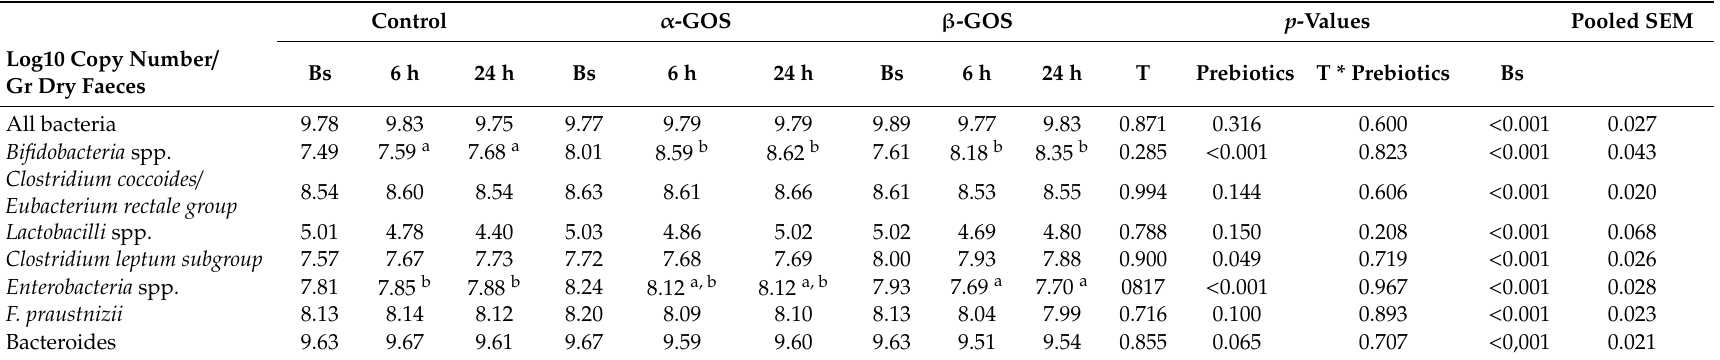
Table 2. Microbiota population from in vitro-fermented infant faecal samples with non-fructosylated α -GOS and commercial β -GOS derived from lactose. Control α -GOS β -GOS p -Values Pooled SEM Log10 Copy Number / Bs Gr Dry Faeces All bacteria